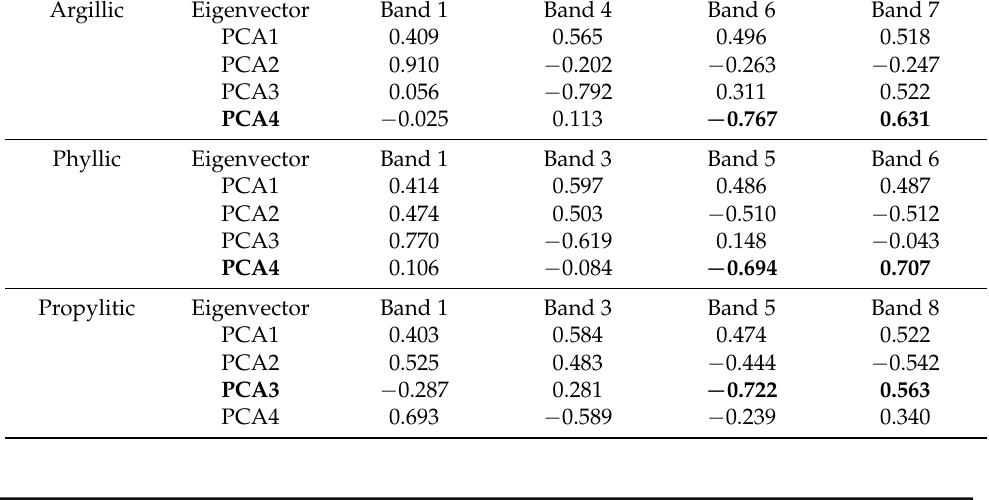
Table 7. The eigenvector matrixes of applying PCA to ASTER selected bands for detailed mapping of argillic, phyllic, and propylitic alteration zones; Bold text represents the selected PCA and the unique eigenvalues.